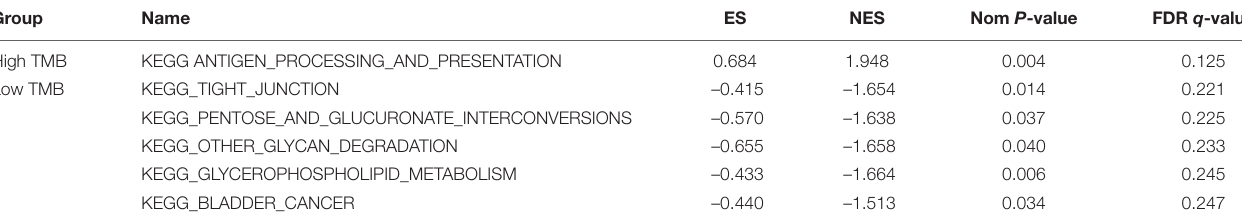
TABLE 3 | GESA for KEGG pathways between low- and high-TMB groups. Group